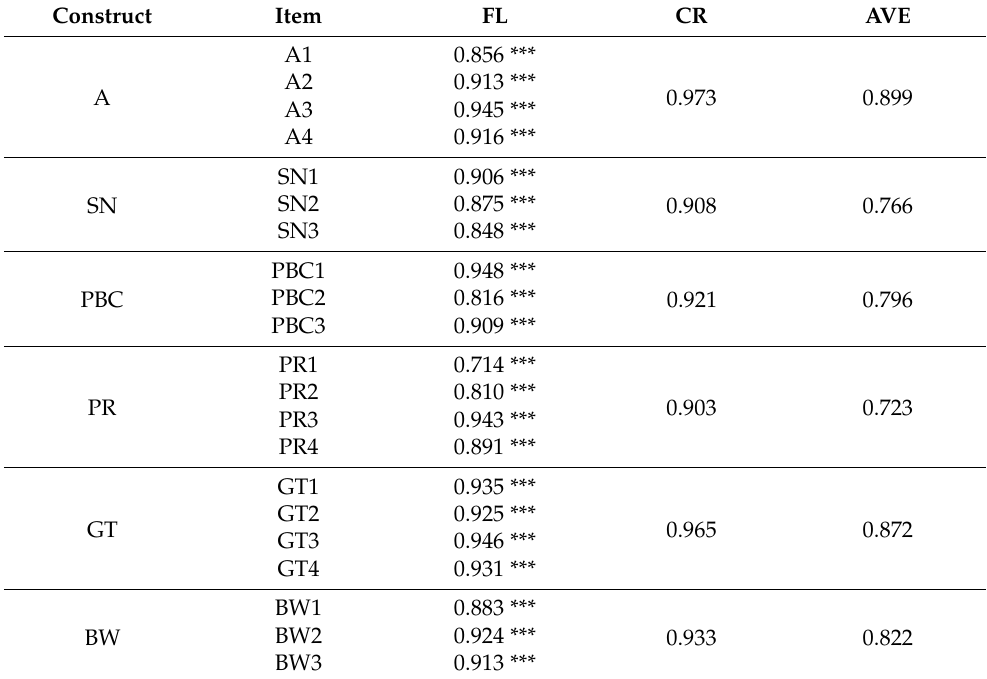
Table 7. Converged validity and standardized factor loadings of the initial measurement model.